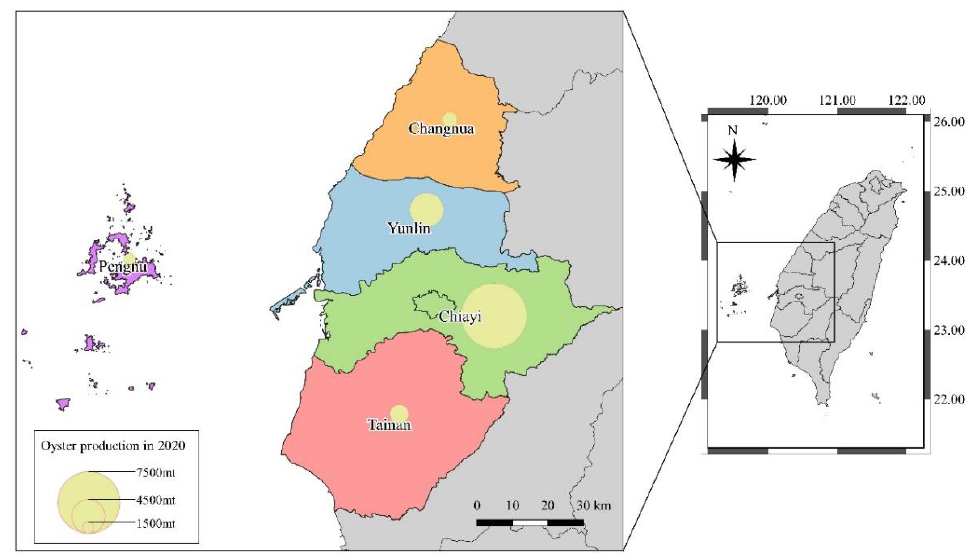
Figure 1. The study area and main oyster farming sites.